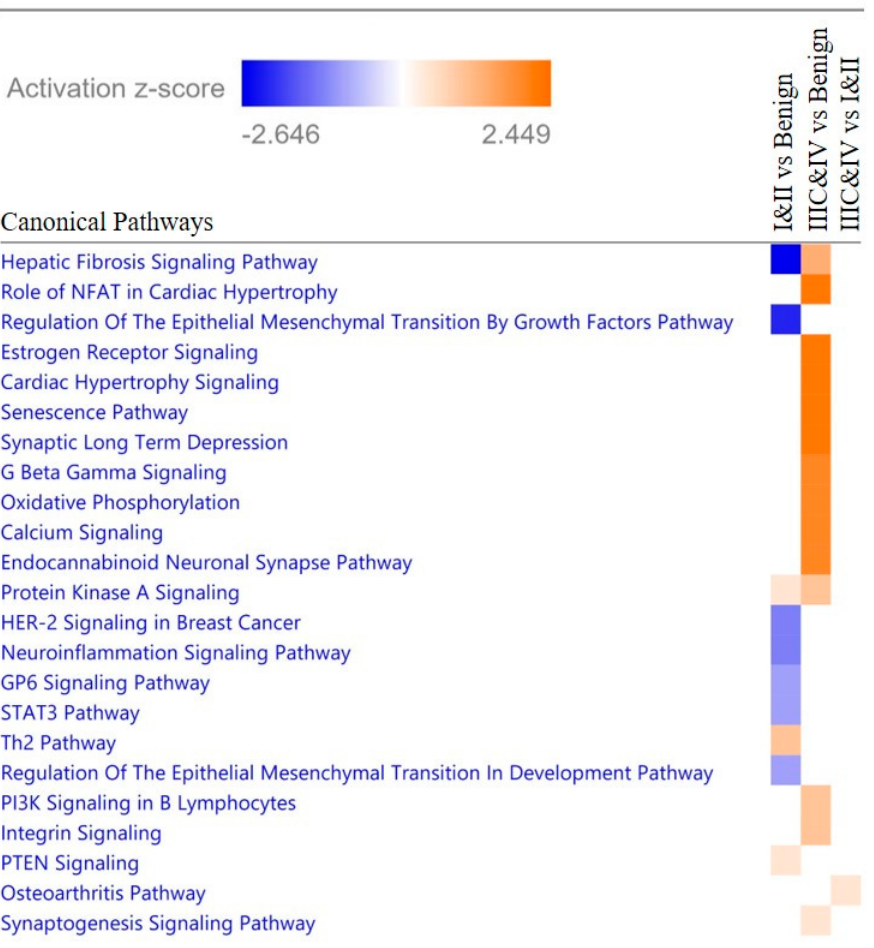
Figure 3. Comparison of z-scores of canonical pathways identified by IPA analysis to be involved in proteins differentially present in sera of groups. proteins differentially present in sera of